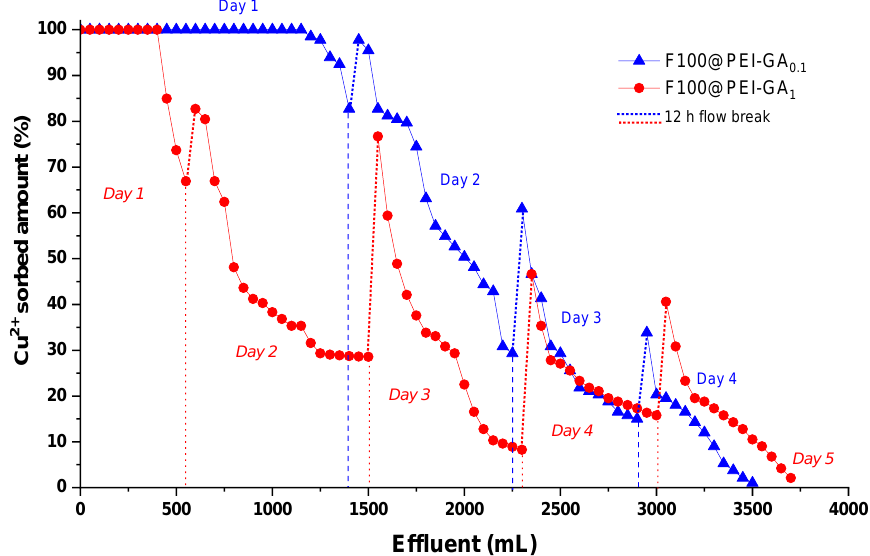
Figure 9. The amount of copper sorbed from an influent solution (C Cu2+ = 2 mg/L) onto F100/PEI- GA r composites (r = 1:10 and 1:1) inside a column operated in a discontinuous mode (with 12 h break of flow before each run).